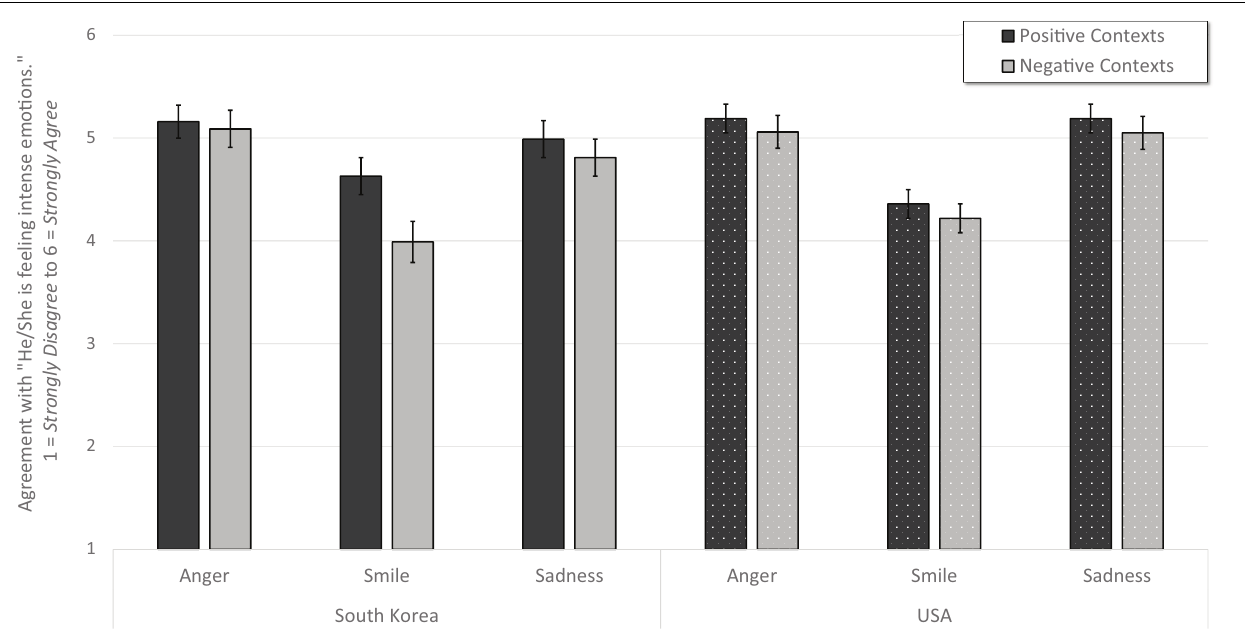
FIGURE 3 | Participants who viewed anger and sadness expressions interpreted that expressers had more intense experiences than those participants who read the same 10 vignettes in the smile condition. Smiles in positive contexts were seen as more intense than in negative contexts for South Korean participants. Error bars indicate ± 2 standard